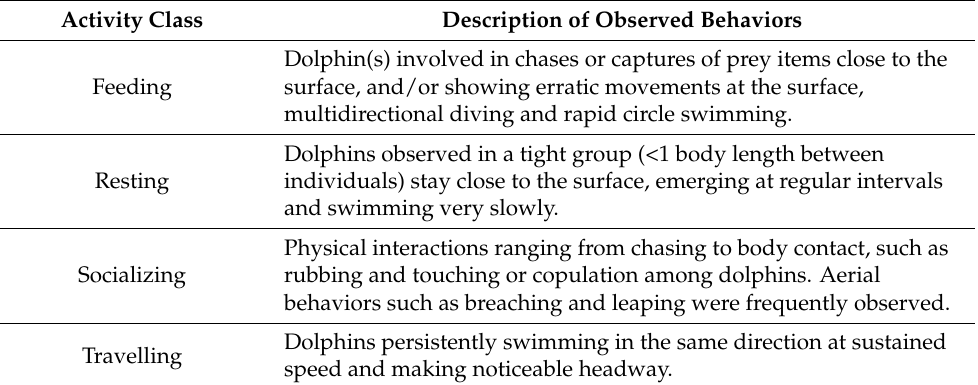
Table 1. Description of behavioral features of odontocetes used to identify the activity